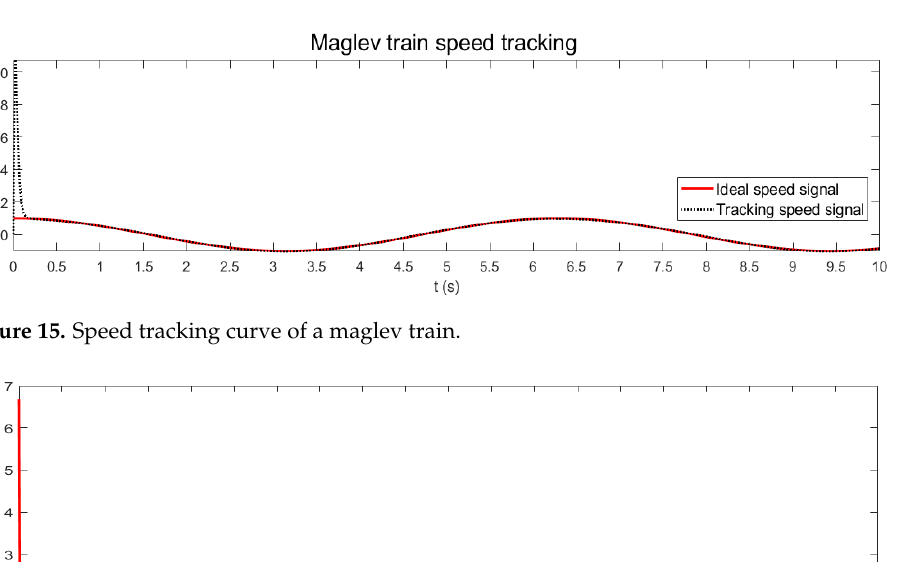
Figure 14. Maglev train displacement tracking curve.